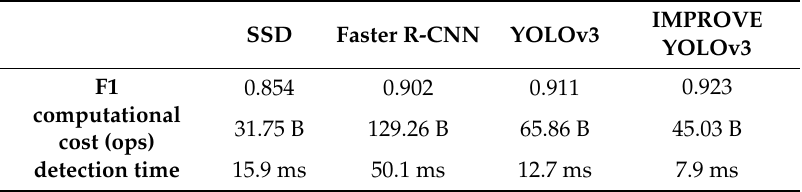
Table 2. F1 Scores and detection time for several models.